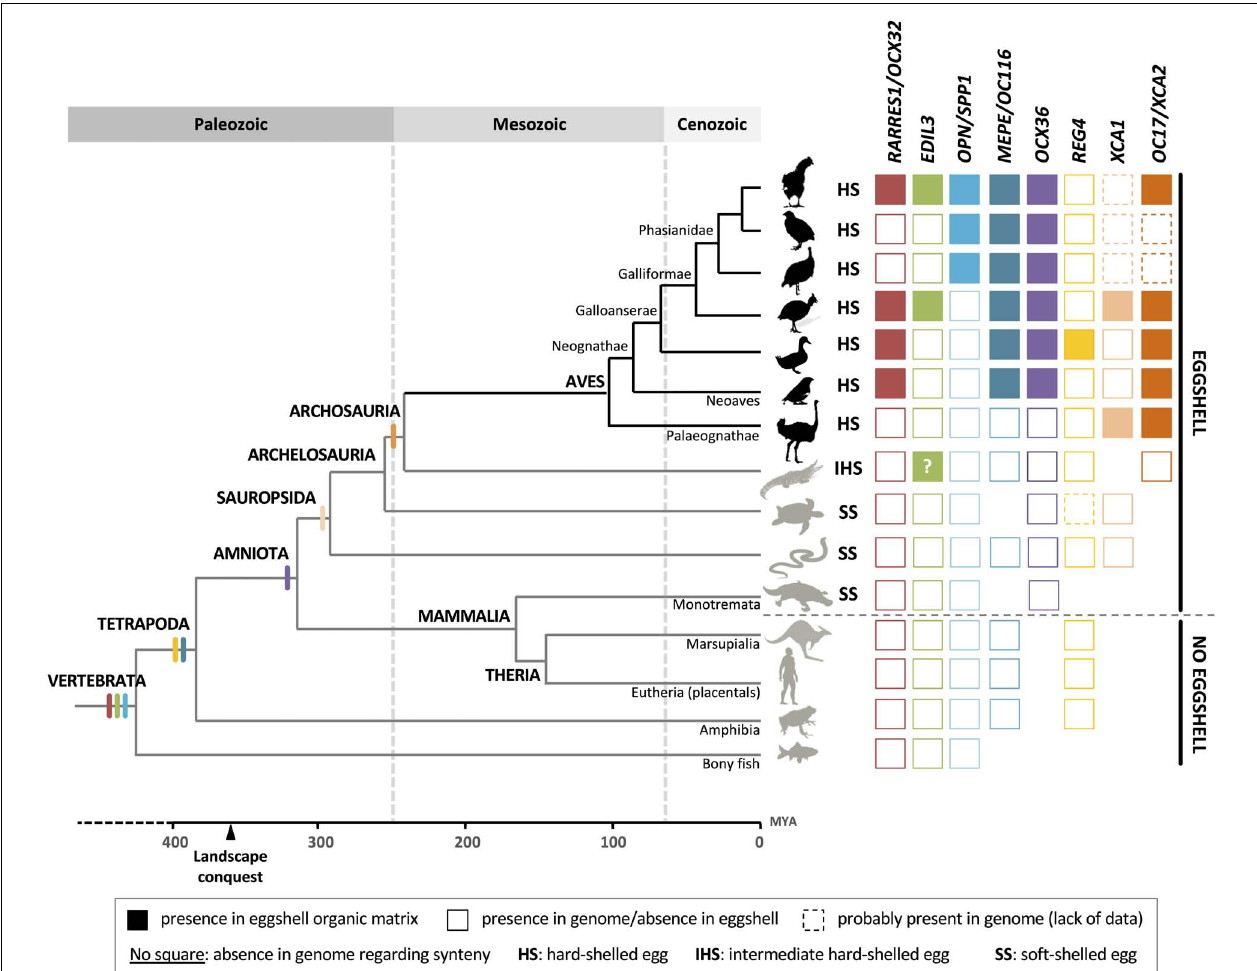
FIGURE 11 | Schematic summary of the presence of genes encoding investigated proteins in vertebrate genomes and the identification of their related proteins in Sauropsida eggshells. Filled squares indicate the presence of the protein in eggshell organic matrix whereas empty squares indicate the presence in genome but the absence in eggshell. Squares with a dotted line indicate a putative presence in genome (lack of data). The absence of square in the figure illustrates an absence in genome with respect to synteny. The “?” in the crocodilian EDIL3 square indicates the uncertainty of true identification of this protein in the crocodilian eggshell proteome (see Supplementary Figure 3 ). Genomic data can come from different species inside the same apical group. The divergent times and topology of the tree are from (www.tolweb.org; Warren et al., 2008; Phillips et al., 2009; Shen et al., 2011; Jarvis et al., 2014; Kapusta et al.,